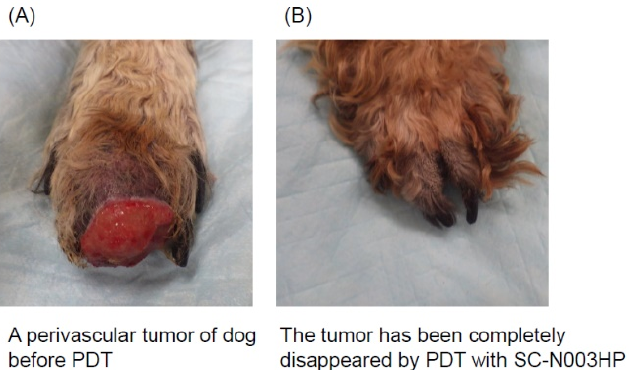
Figure 6. A case of dog with a perivascular tumor on the foot (stage T2N0M0) cured by PDT with SC-N003HP. ( A ) The perivascular tumor on the dog’s foot before PDT; ( B ) the tumor completely disappeared using PDT with SC-N003HP.